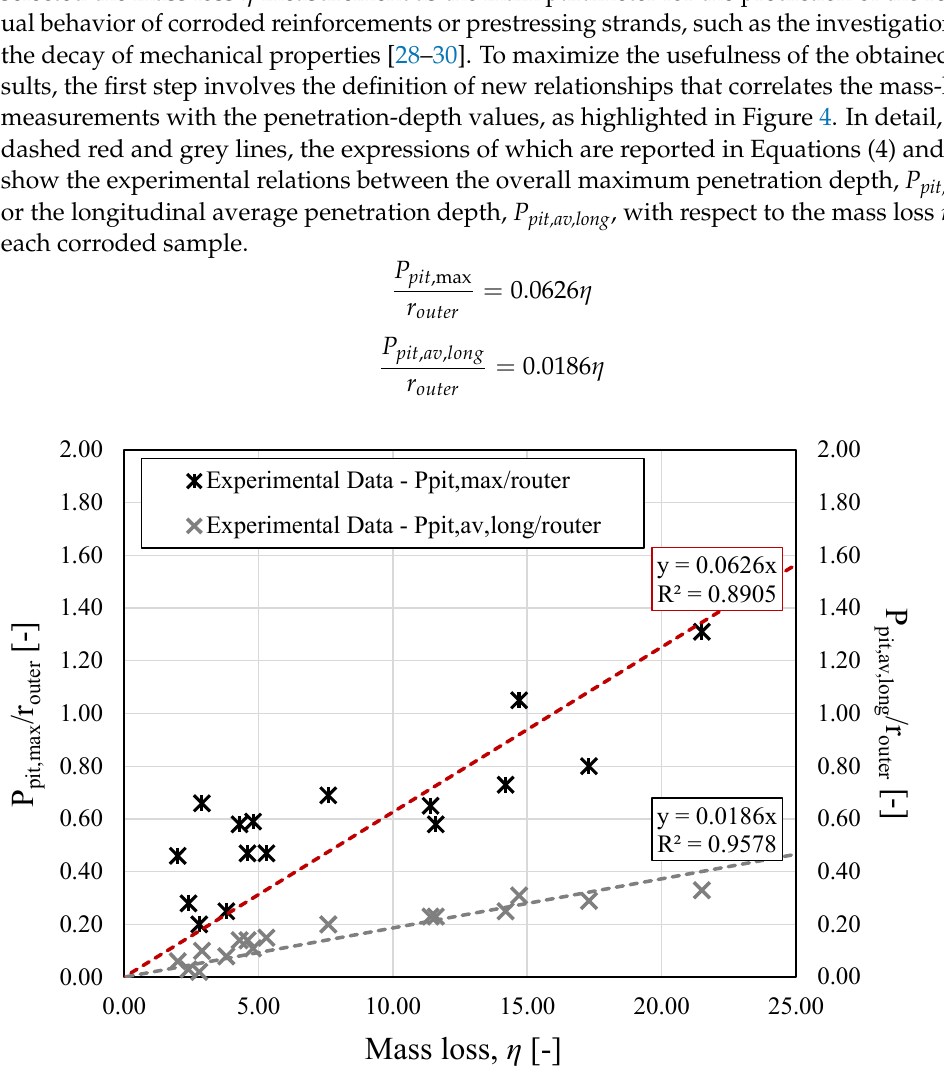
Figure 4. Relationships of P pit,max / r outer and P pit,av,long / r outer versus mass loss η . Based on the obtained outcomes, a significant correlation between the analyzed data is observed, as confirmed by the coefficients of correlation R 2 equal to 0.89 and 0.96